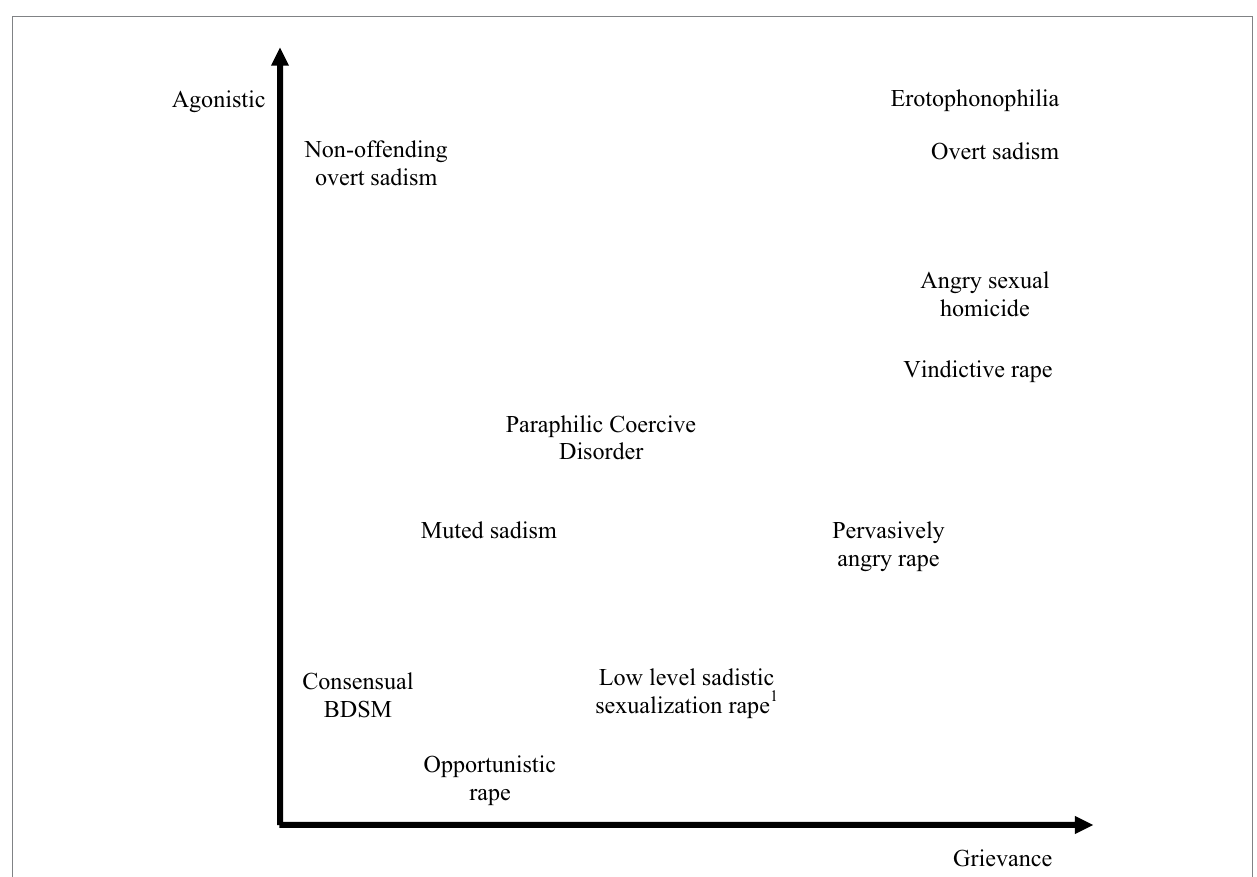
FIGURE 1 The grievance-agonistic model of grievance fueled sexual violence. 1 Non-sadistic sexualization rapist in the MTC